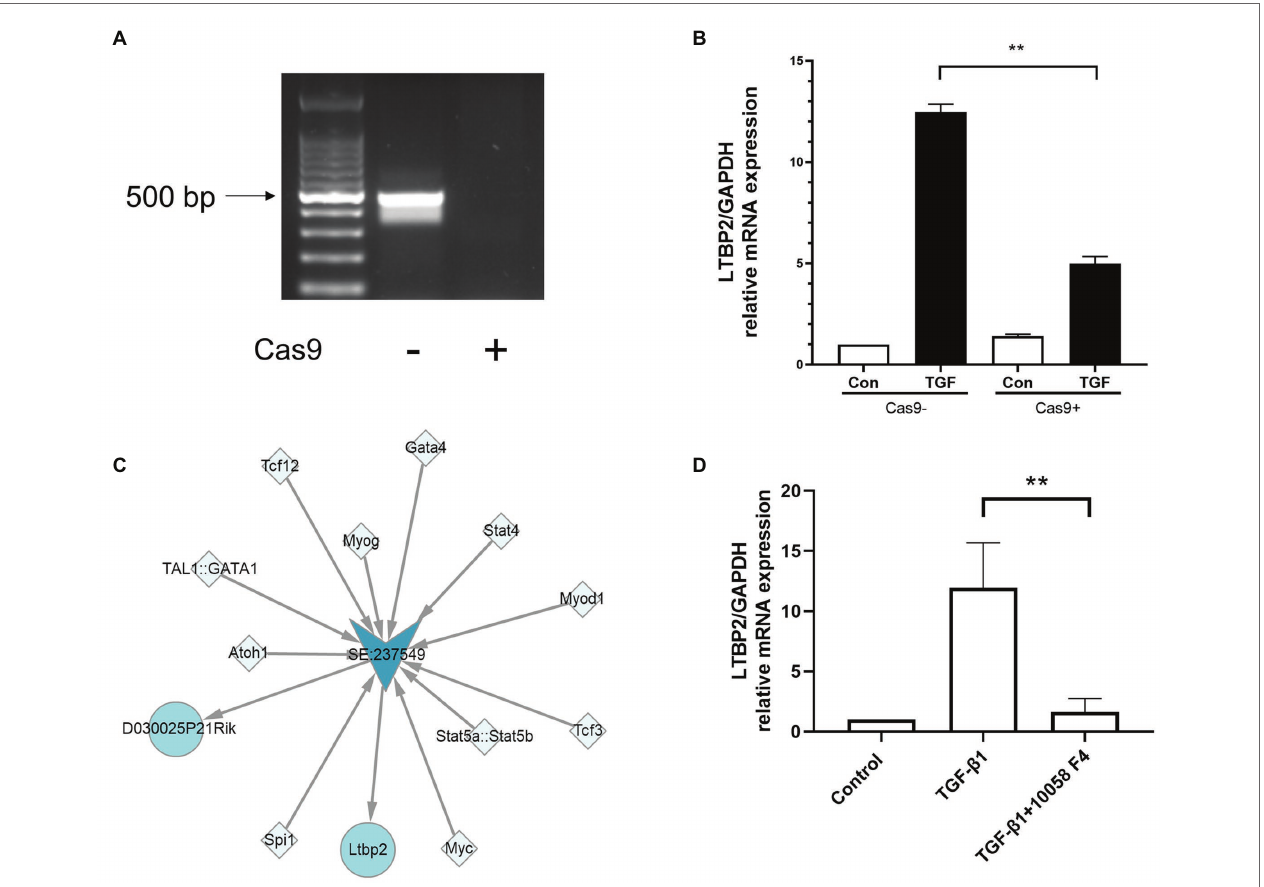
FIGURE 5 | Knockout of super-enhancer sequences and inhibition of myc decreased LTBP2 expression. (A) Genomic DNA of NIH/3 T3 cells transfected with or without a CRISPR/Cas9 knockout plasmid was extracted. PCR was used to detect the expression of targeted genes. Products were electrophoresed in a 1% agarose gel, and images were captured under ultraviolet light. (B) The mRNA expressions of LTBP2 in NIH/3 T3 cells transfected with or without a CRISPR/Cas9 knockout plasmid were detected by real-time PCR after TGF- β 1 stimulation for 12 h. (C) TFs binding the LTBP2 super-enhancer (SE:237549). Squares represent TFs. Arrows represent the super-enhancer. Circles represent targeted genes. (D) The mRNA expressions of LTBP2 in NIH/3 T3 cells were detected by real-time PCR after 5 ng/ml TGF- β 1 and 20 μ M myc inhibitor (10058-F4) treatment for 12 h. Data presented as mean ± SD, n = 3. ** p <